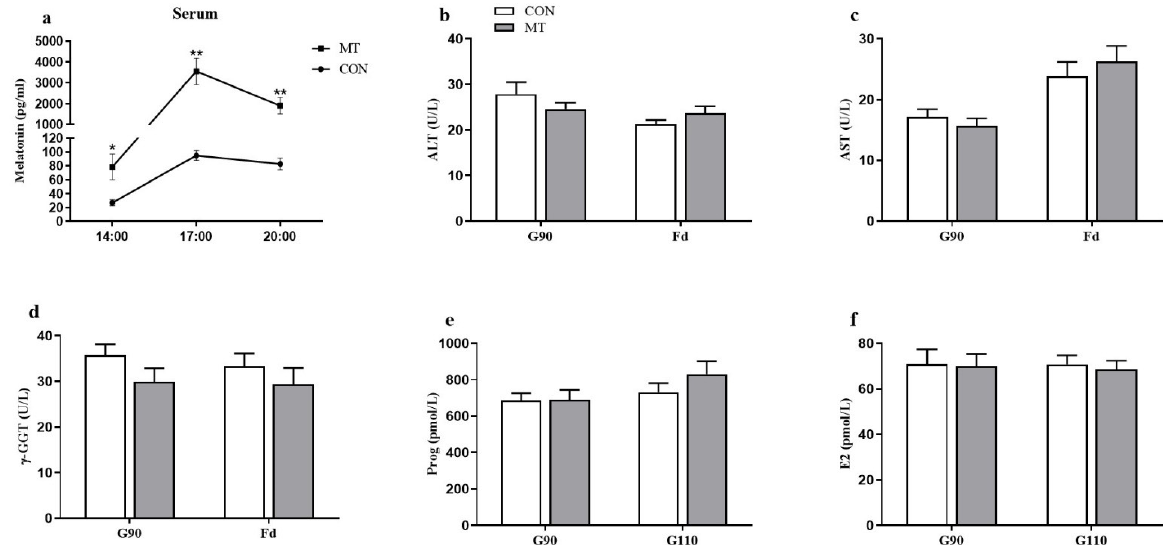
Figure 2. Effects of maternal MT supplementation during gestation on hormonal and biochemical parameters in the serum and placenta. ( a ) MT concentration in maternal serum on d 102 of gestation ( n = 7/group). ( b ) ALT concentration, ( c ) AST concentration, ( d ) γ -GGT concentration, ( e ) Prog concentration, and ( f ) E2 concentration in maternal serum ( n = 8/group). Data are presented as means ± SEM. * p < 0.05, ** p < 0.01. CON = control, MT = melatonin, G90 = d 90 of gestation, G110 = d 110 of gestation, Fd = farrowing day, ALT = alanine aminotransferase, AST = aspartate aminotransferase, γ -GGT = gamma-glutamyl transpeptidase, Prog = progesterone, E2 = estradiol-17 β .